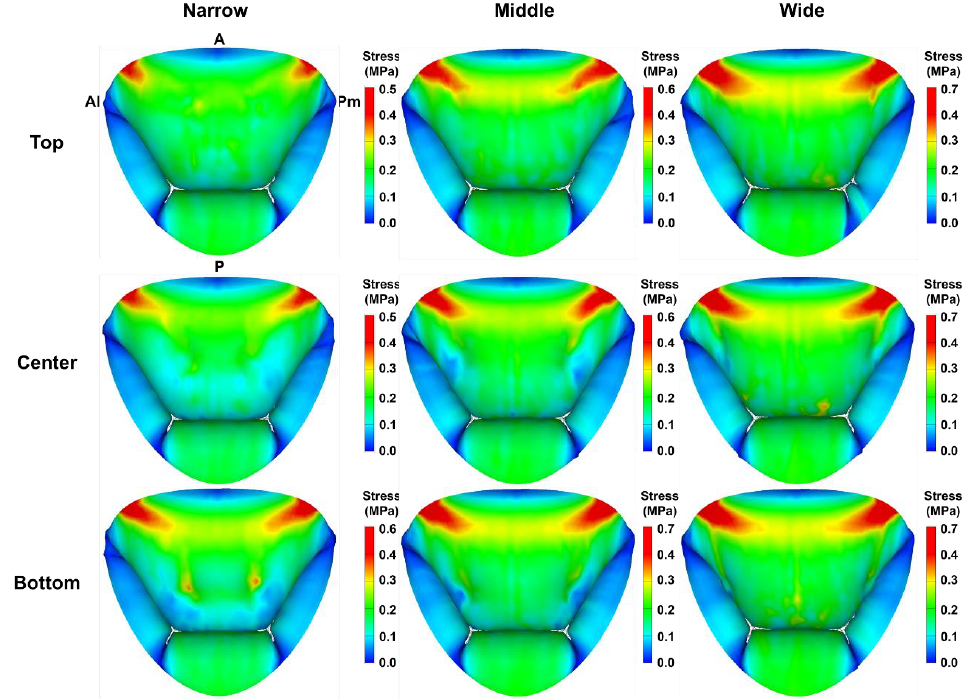
Figure 4. Stress distributions on the MV leaflets at peak systole with respect to alteration of the SC insertion location (atrial viewpoint). A — anterior; Al — anterolateral; P — posterior; Pm — posteromedial.